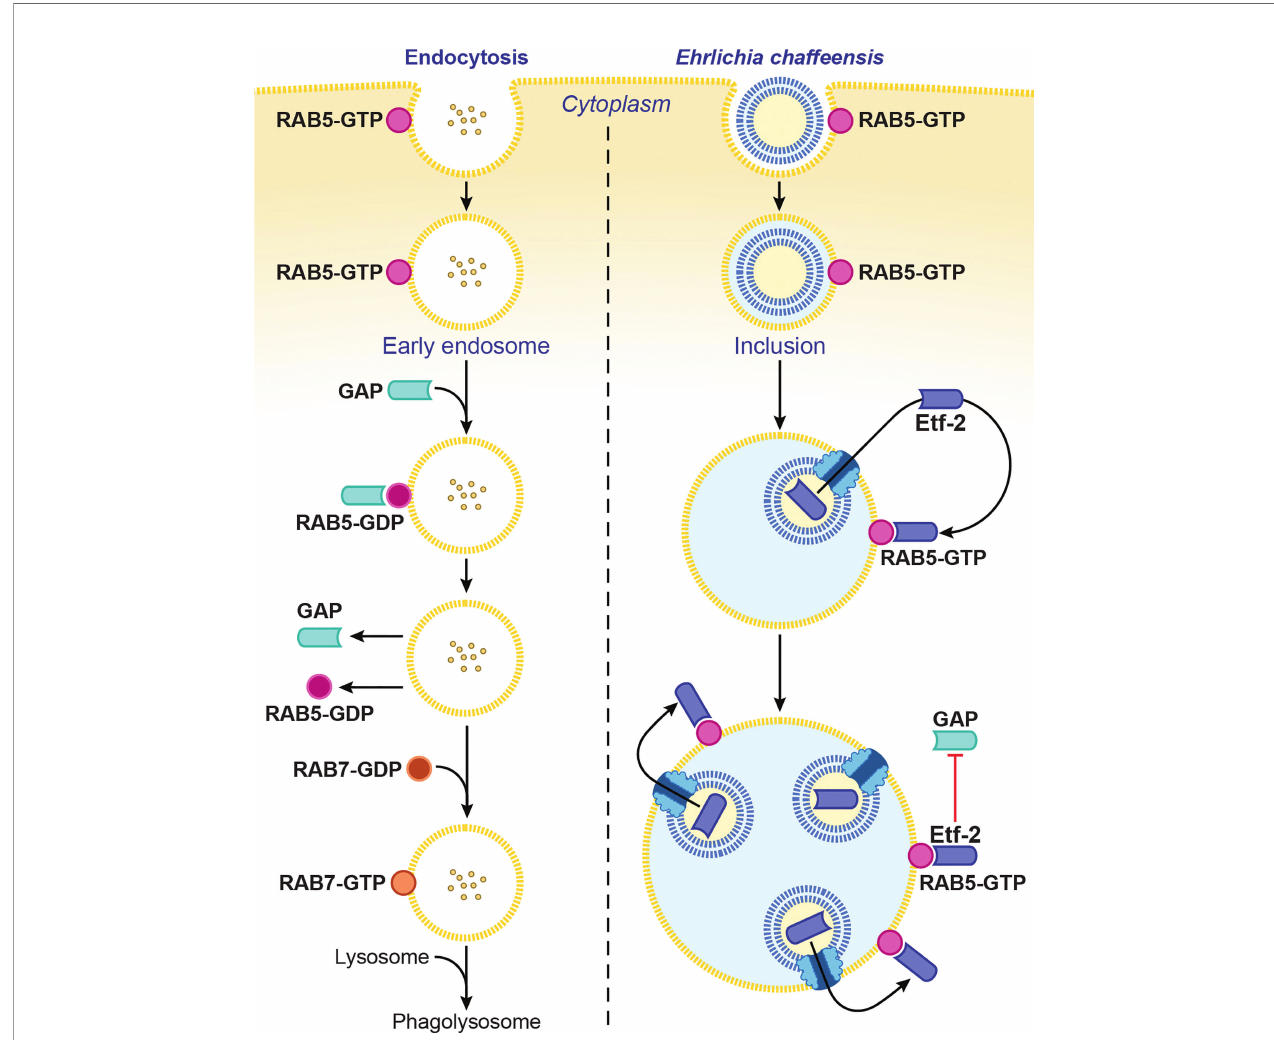
FIGURE 3 | Ehrlichia chaffeensis Etf-2 binds RAB5-GTP and blocks RABGAP5 from acting on RAB5. RAB5-GTP hydrolysis by the RAB5-speci fi c GAP is required for endosome maturation and lysosomal fusion (left). Etf-2 is responsible for blocking lysosomal fusion with E. chaffeensis inclusions by localizing to E. chaffeensis inclusions via binding to RAB5-GTP and competitively blocking RABGAP5 from acting on RAB5 on the inclusion surface (right). The drawing is from (Yan et al., 2018), copyright 2018